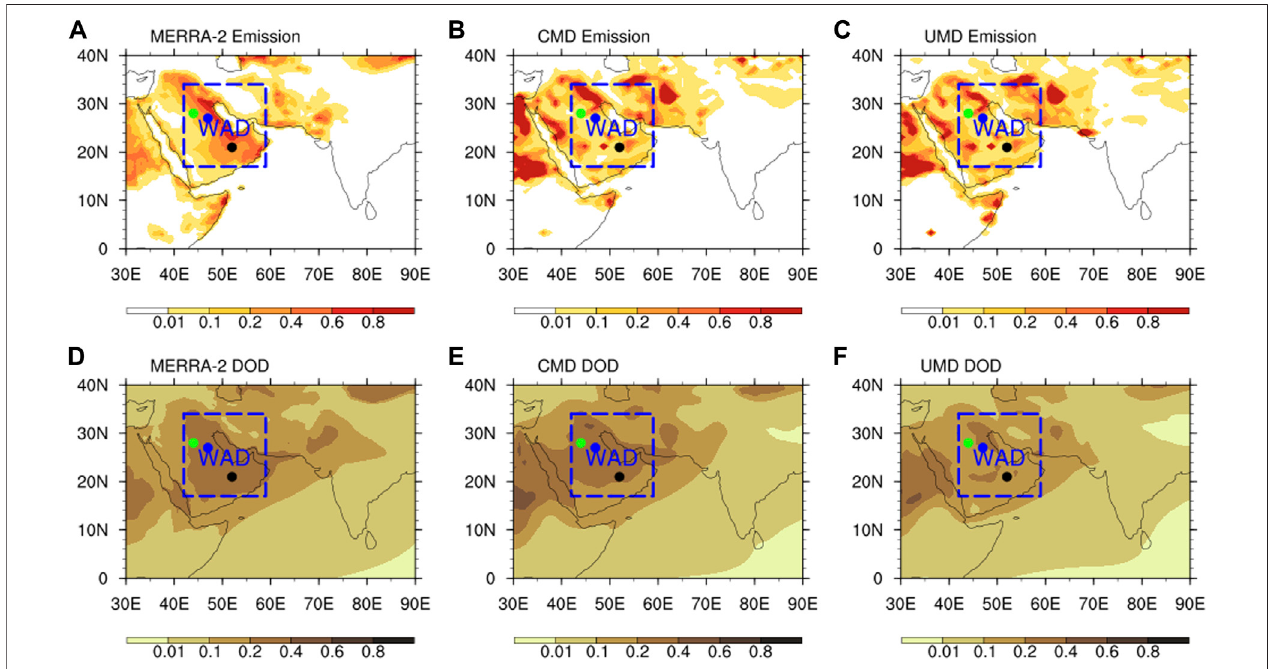
FIGURE1| Distributionsofannualaverageddust emission fl ux( A – C ,unit: 10 − 8 kg/m 2 /s)and DOD (D – F) from theMERRA-2 reanalysis (A,D) ,theCMDsimulation (B,E) and the UMD simulation (C,F) . The dashed boxes represent the regions of west Asian deserts (WAD, 17 – 34 ° N, 42 – 59 ° E). The green dots represent the Nafud desert, the blue dots represent the Dahna desert and the black dots represent the Rubal Khali desert.